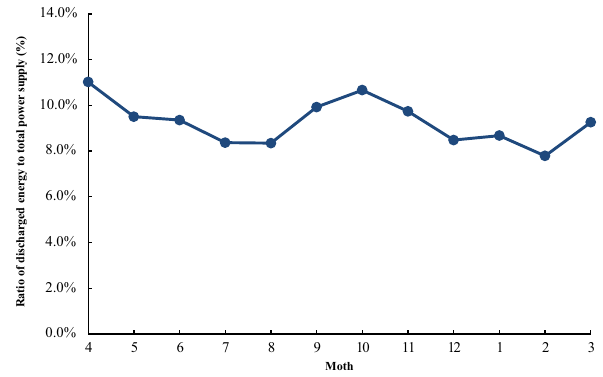
Fig. 12 Ratio of discharged energy to total energy supply from